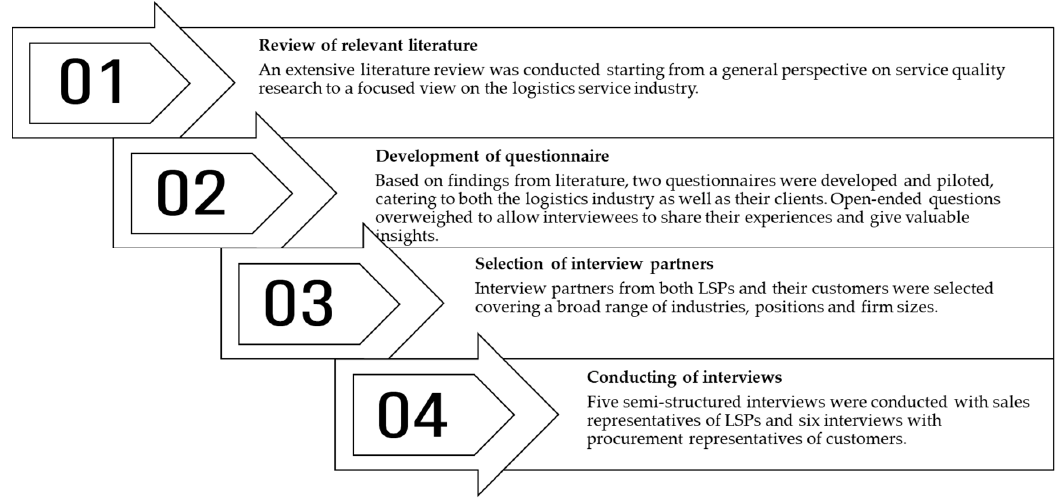
Figure 4. Structure of the data collection process.